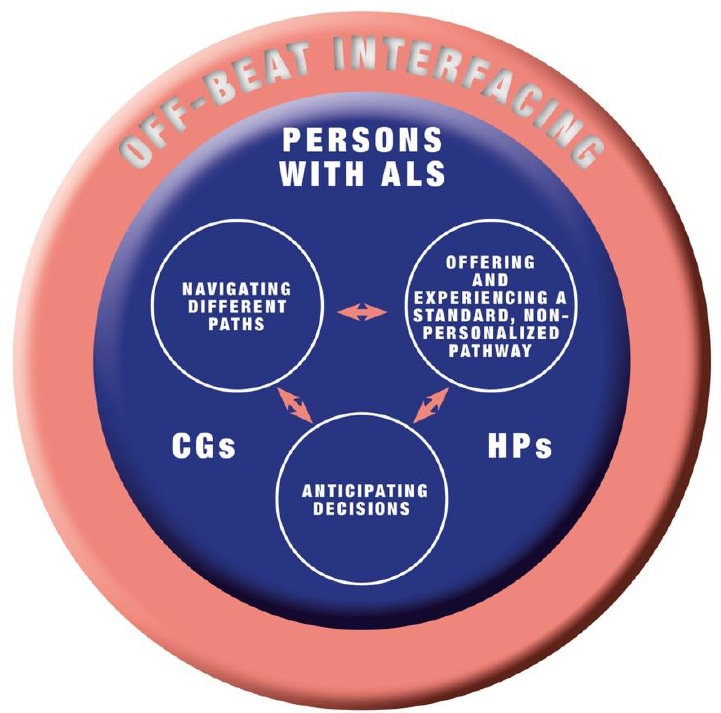
Figure 1. The conceptual model of “off-beat